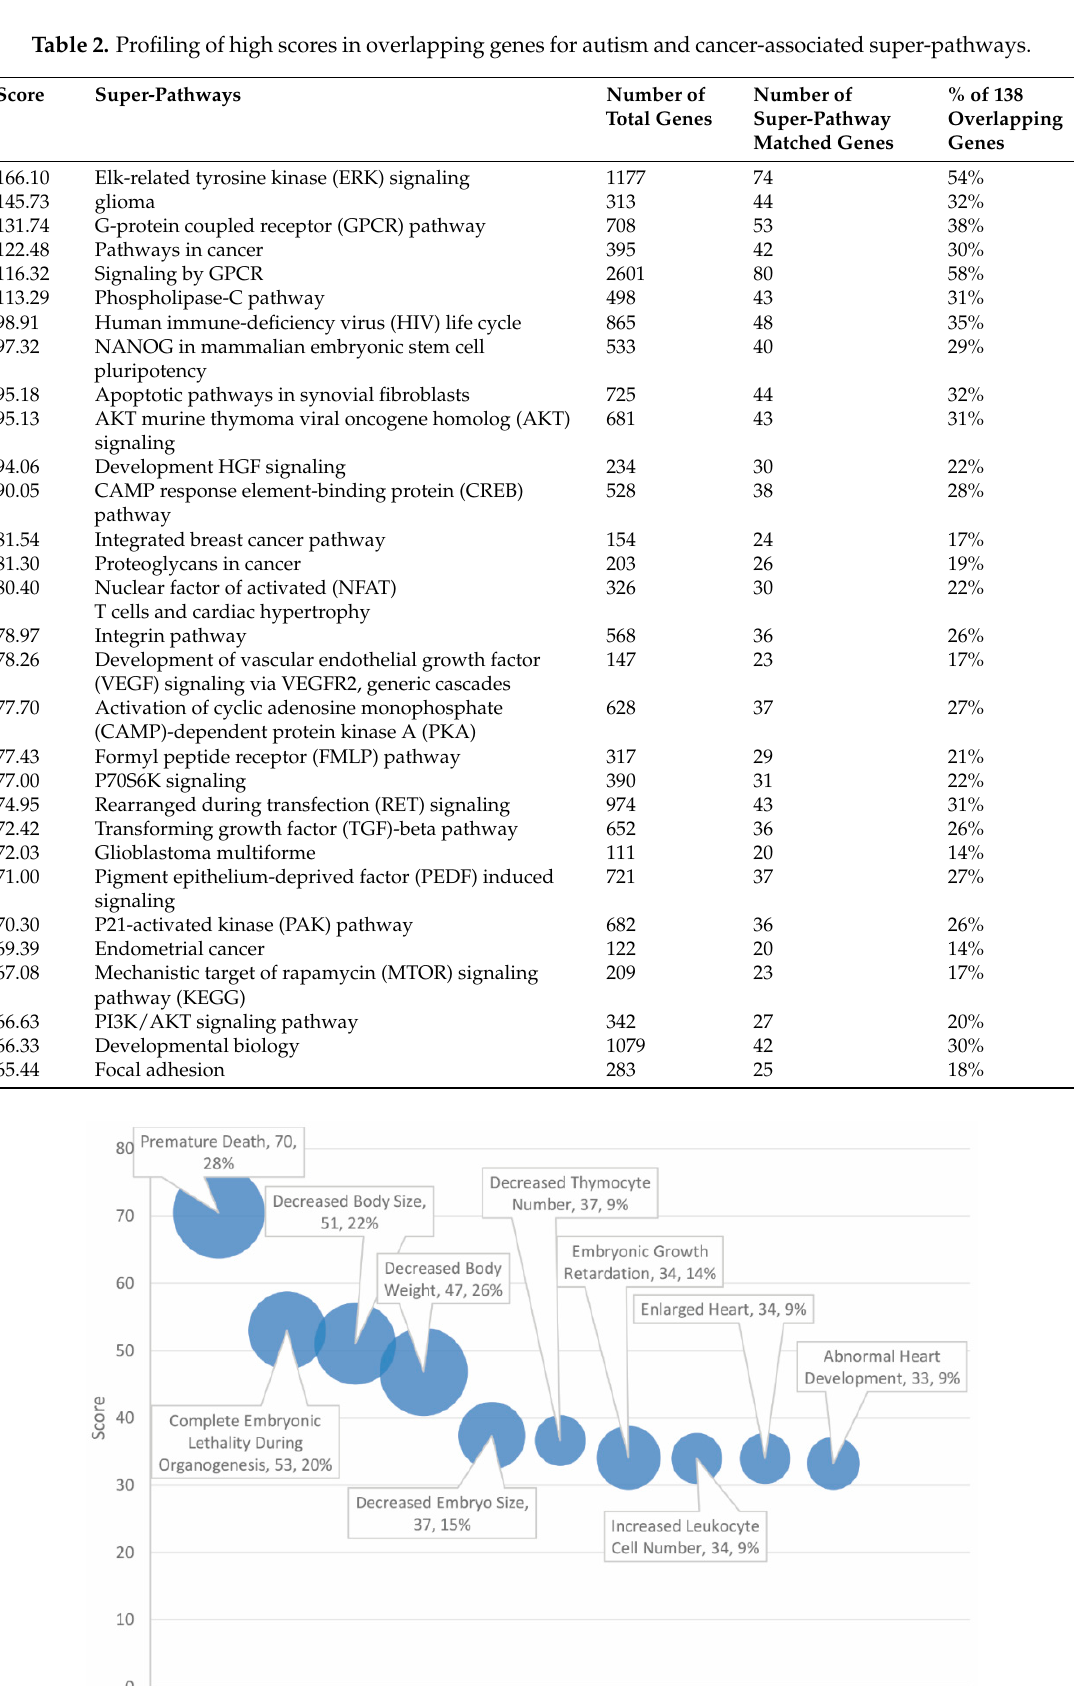
Figure 2. Phenotypes ranked by score and match rate (size of circle) for top ten phenotypes. Statistically significant Gene Ontology (GO) biological processes are presented in Table 3, which are limited to the top 30 of 153 total high-scoring matches. The top three entries directly relate to the regulation of gene expression. These include “positive regulation of transcription, DNA-templated”, “positive regulation of transcription from RNA polymerase II promoter”, and “positive regulation of gene expression”, which exhibited matching rates of 21%, 25%, and 15%, respectively, with the combined 138 overlapping gene set (see Figure 3). Table 3. Profiling of high scores in overlapping genes for autism and cancer-associated Gene Ontology (GO) biological processes. Score